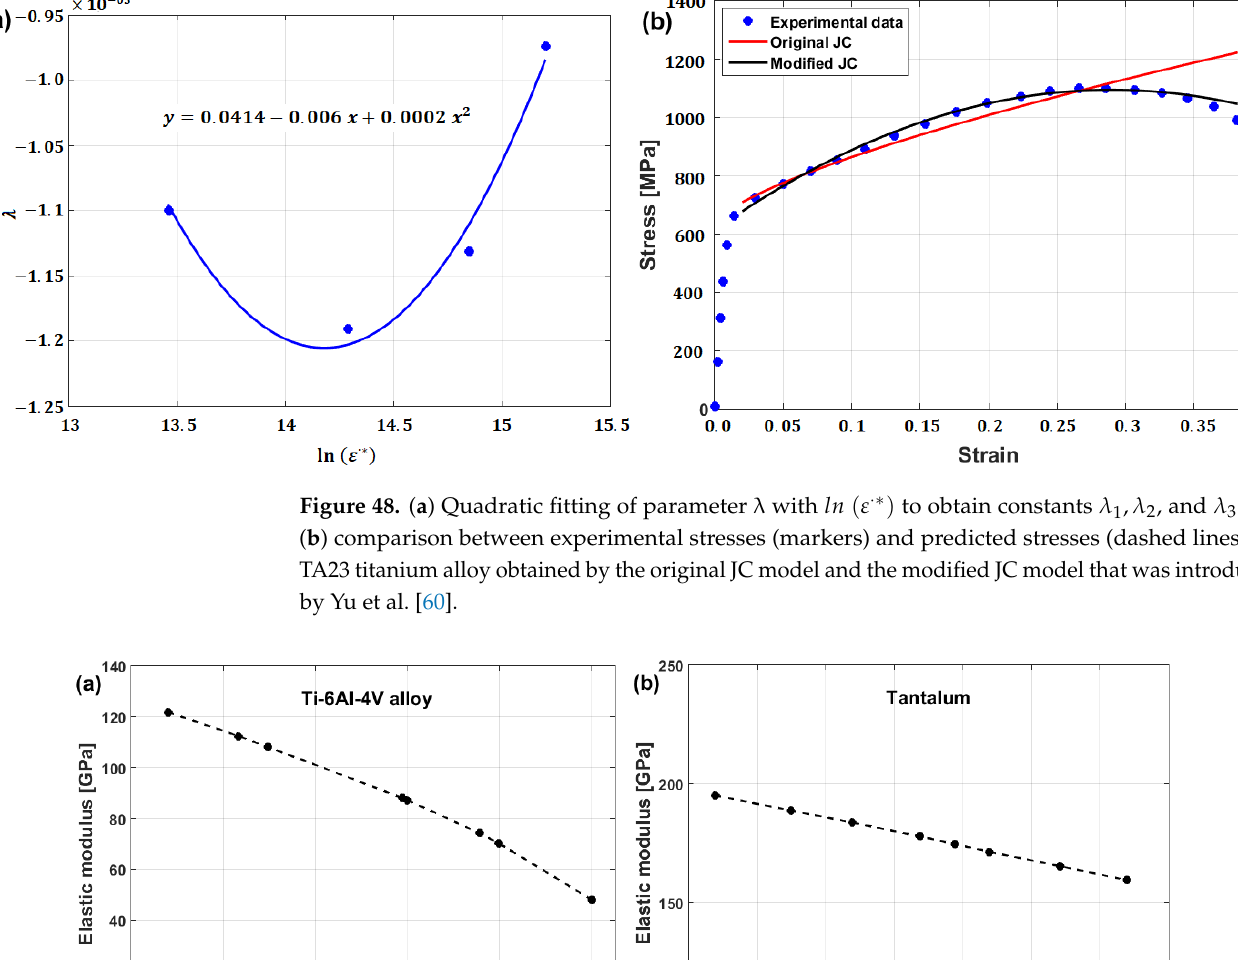
Figure 48. ( a ) Quadratic fitting of parameter λ with 𝑙𝑛 (𝜀 ∙∗ ) to obtain constants 𝜆 1 , 𝜆 2 , and 𝜆 3 and ( b ) comparison between experimental stresses (markers) and predicted stresses (dashed lines) for TA23 titanium alloy obtained by the original JC model and the modified JC model that was introduced by Yu et al. [60].